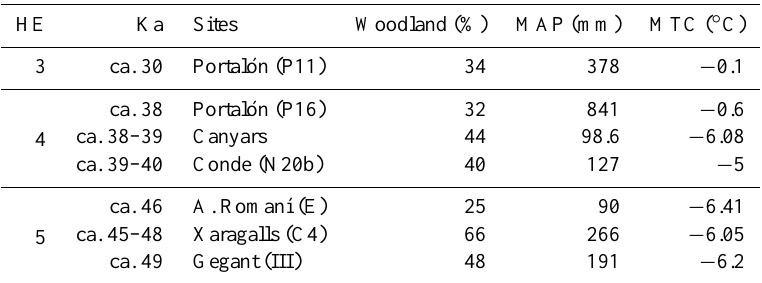
Table 5. Relation between woodland percentage, mean annual precipitation and mean temperature of coldest month for the different sites where the H3 to H5 events have been detected. HE Ka Sites Woodland (%) MAP (mm) MTC ( ◦ C) ca.